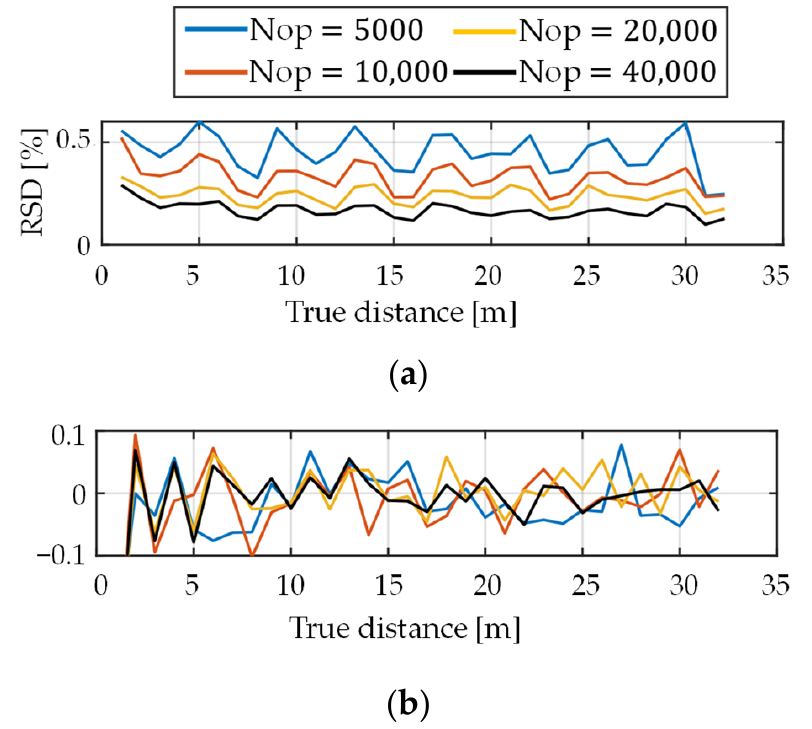
Figure 8. Results of single path simulation when depth-dependent decay of the number of photons is considered. ( a ) Relative standard deviation and ( b ) relative mean error of the estimated depth.